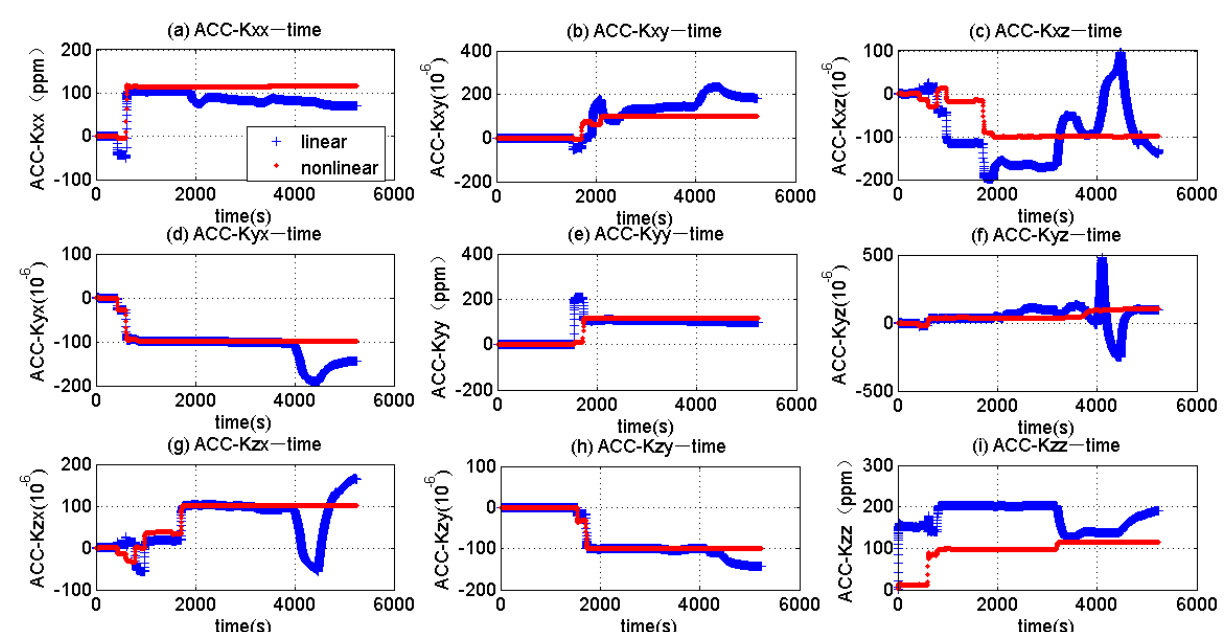
Figure 7. Estimated results of the scale factor error and misalignment error (ACCs).